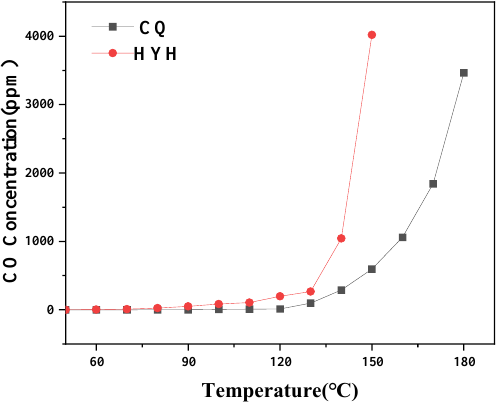
Figure 9. Changes in CO concentration in two kinds of coal samples.